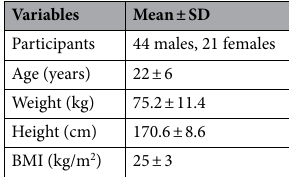
Table 1. Participants’ anthropometric and physiological characteristics. Kg kilograms, cm centimeters, m meters, BMI body mass